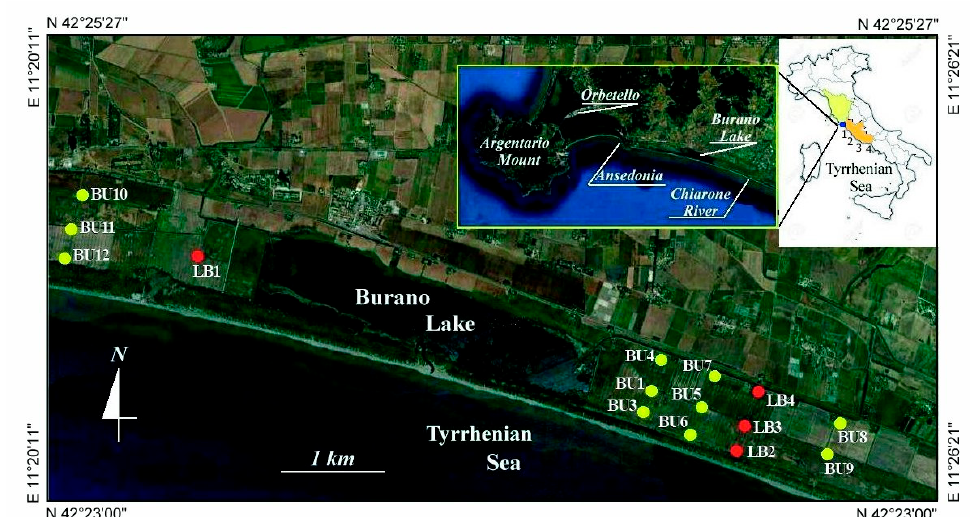
Figure 1. Location of the studied area. The position of the continuous (red dot) and percussion (yellow dot) drillings is indicated. The regions Tuscany (yellow) and Latium (orange) are indicated in the box at the top right. The numbers indicate the position of Lido di Tarquinia (1), Tiber river mouth (2), M. Circeo promontory (3) and Garigliano river mouth (4). From Google Earth image 2019. WGS84 Geographic Coordinate System refers to the vertices.